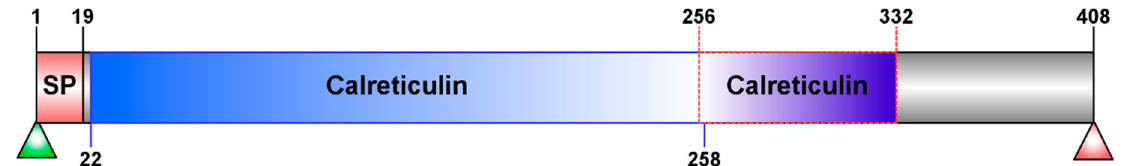
Figure 1. Amino acid sequence structure analysis of the calreticulin (PvCRT) in P. vindemiae . Blue boxes denoted two conserved “calreticulin” domains (22–258 aa and 256–332 aa). Initiation codon and termination codon were highlighted with triangles. SP: signal peptide (1–19 aa).